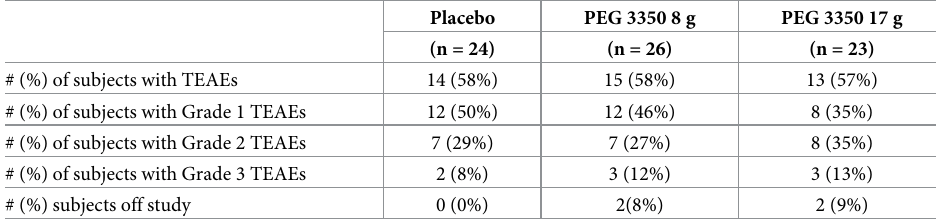
Table 3. Adverse event